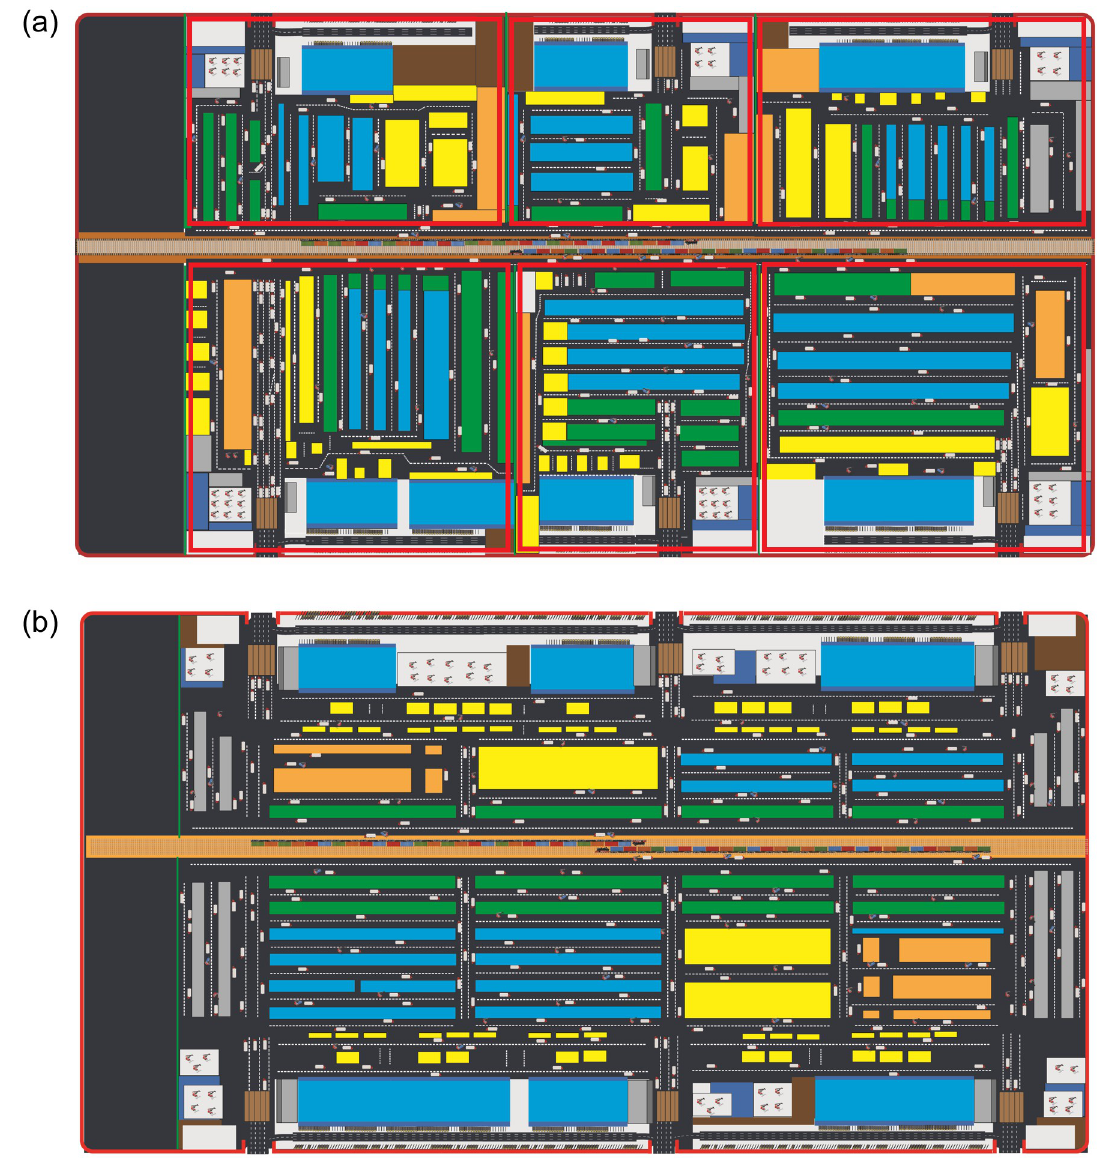
Fig 1. Layouts of the current and the projected LICD by PAT. (a) The current LICD layout with six independent gate operators. (b) The new LICD layout.